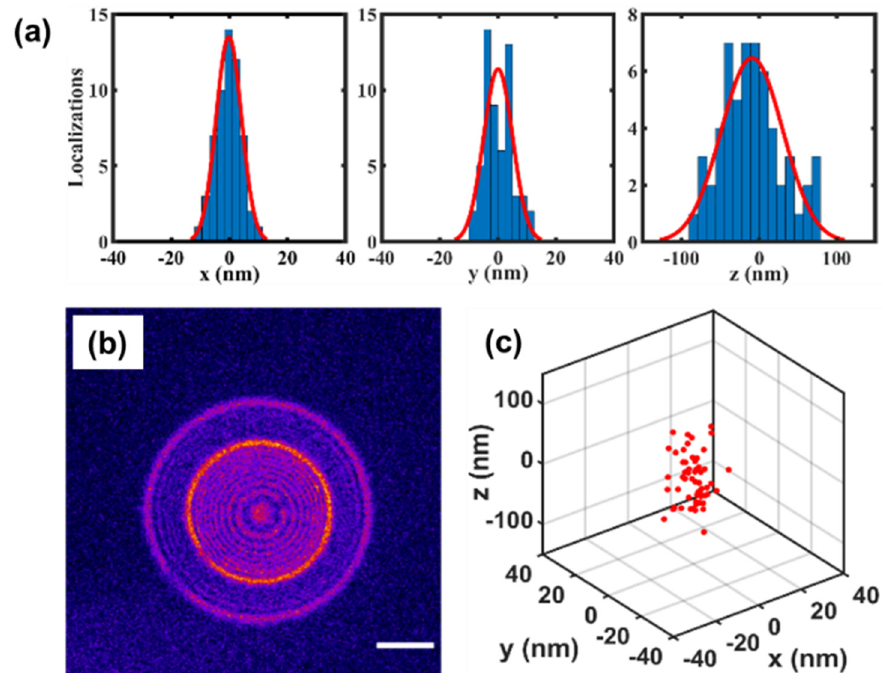
Figure 23. 3D localization of a single 0.1 µm fluorescent bead. ( a ) Histograms of 68 localizations in x , y , and z of one single 0.1 µm red (580/605) fluorescent bead on a coverslip. The standard deviations of the measurements are σ x = σ y = 5 nm, and σ z = 40 nm. ( b ) Representative hologram of a single bead acquired in one 50 ms exposure. Scale bar is 50 µm. ( c ) Scatter plot of localizations. Reprinted with permission from [40].